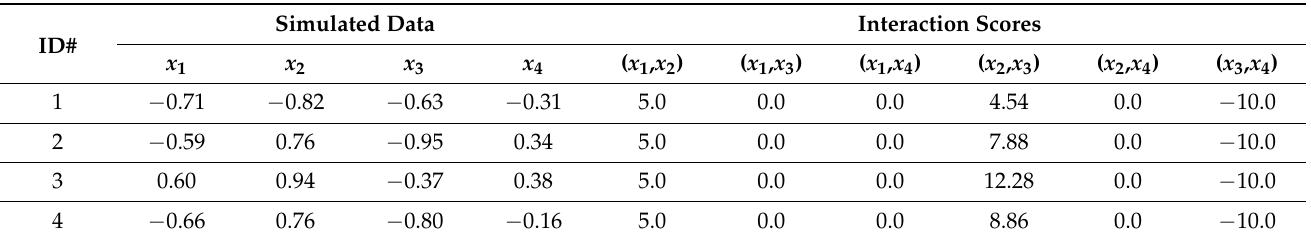
Table 5. The individual-level interaction scores of four randomly selected individuals from Simulation Data